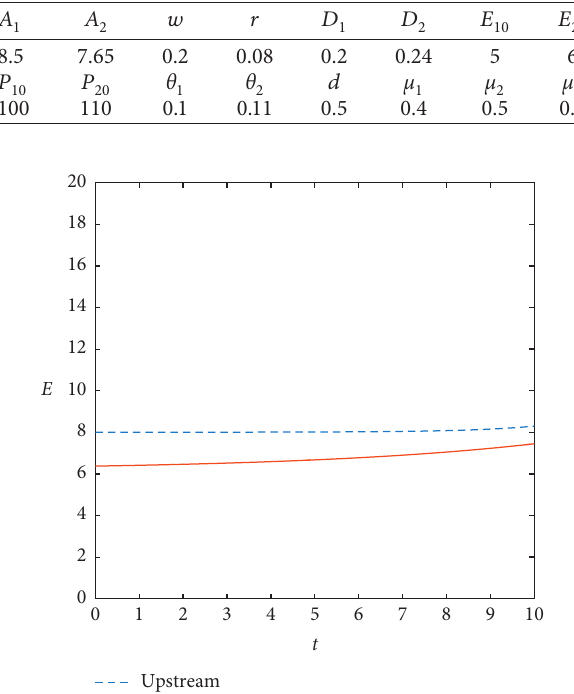
Table 1: The parameters used in the numerical example.